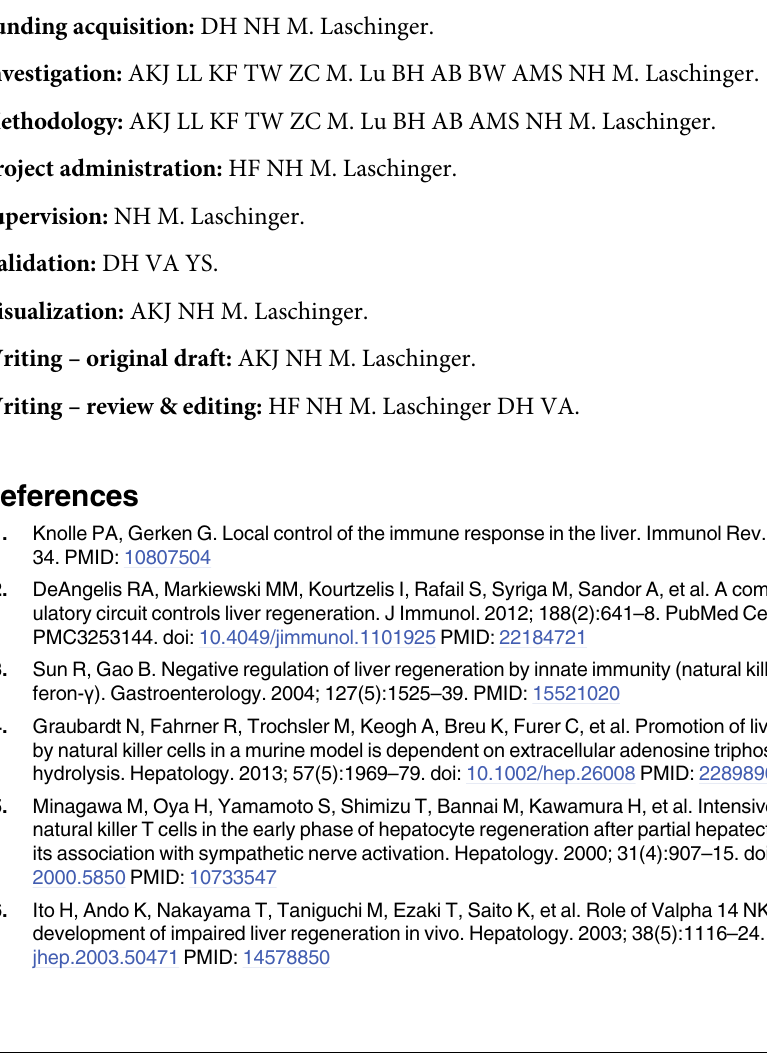
S3 Fig. Reduced numbers of NKT cells within the regenerating liver in absence of LFA-1. (A) Detection of TCRß + α GalCer/CD1d-dextramer + cells within the liver of WT or LFA-1 -/- mice before (ex vivo) or 48h post PH and LPS using flow cytometry. One representative assay is shown; 20.000 events per dot plot are shown. (B) Quantification of TCRß + α GalCer/CD1d- dextramer + NKT cell staining depicted in (A); 0h: n = 4, 24h: n = 3, 48h: n = 3.